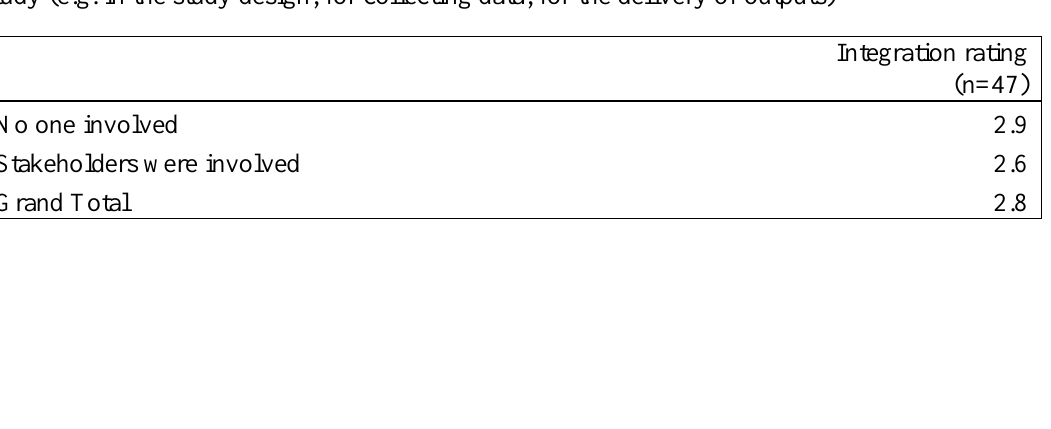
Table A4.6. Integration scores for studies that did/did not involve stakeholders at some point in the study (e.g. in the study design, for collecting data, for the delivery of